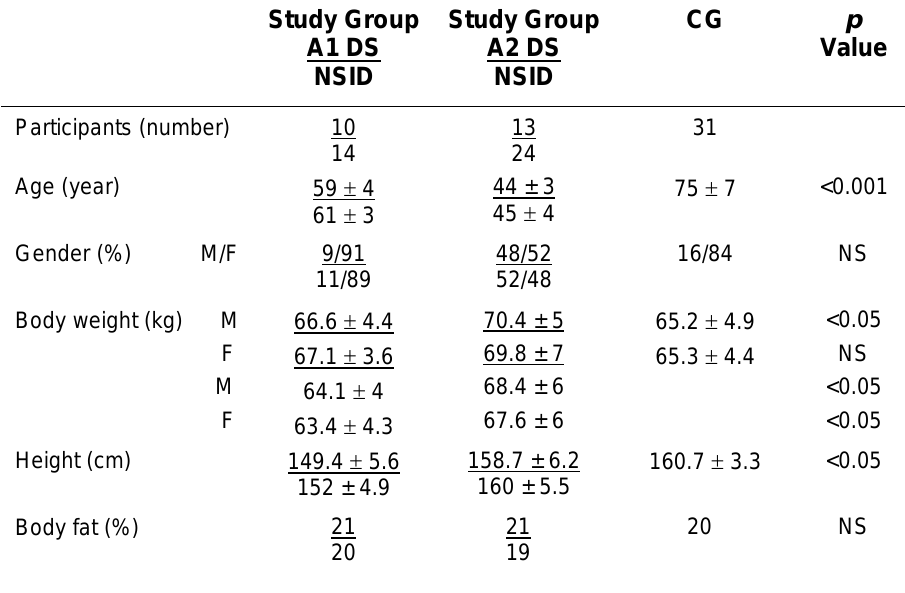
Demographic, Body Composition, and Medical Characteristics of